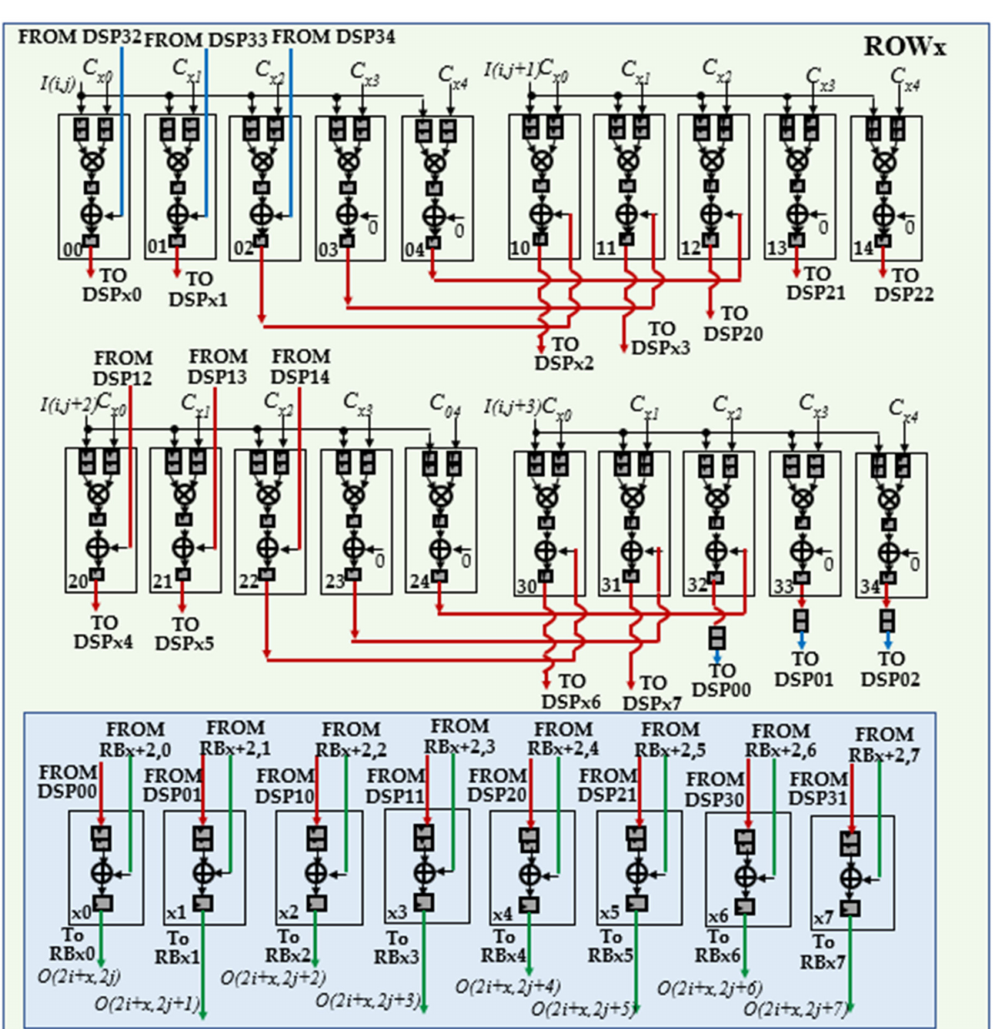
Figure 6. The architecture of the module Row x for P N = 4, K = 5, S =